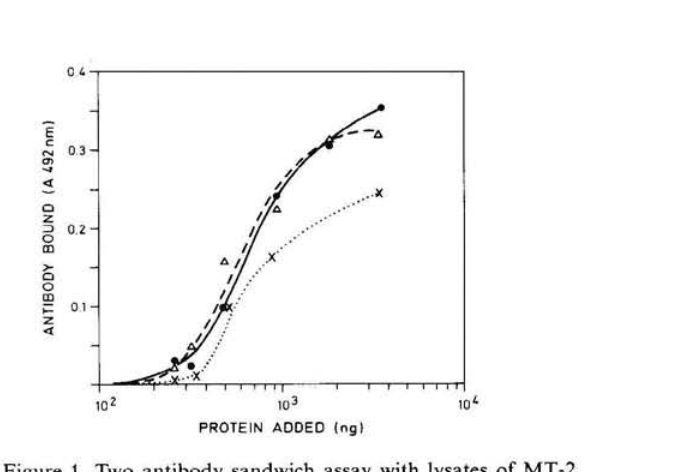
Figure 1. Two antibody sandwich assay with lysates of MT-2 cells. Class I HLA molecules from cell lysate were allowed to react with the anti-HLA monoclonal antibody W6/32 which had been fixed to microtiter plates. The pterin binding sites of the class I HLA antigen were then determined by the anti- idiotype monoclonal antibody NS7. Daudi cell lysates (which lack class I HLA antigen) served as a control for unspecific reaction. Dilution of the W6/32 antibody: